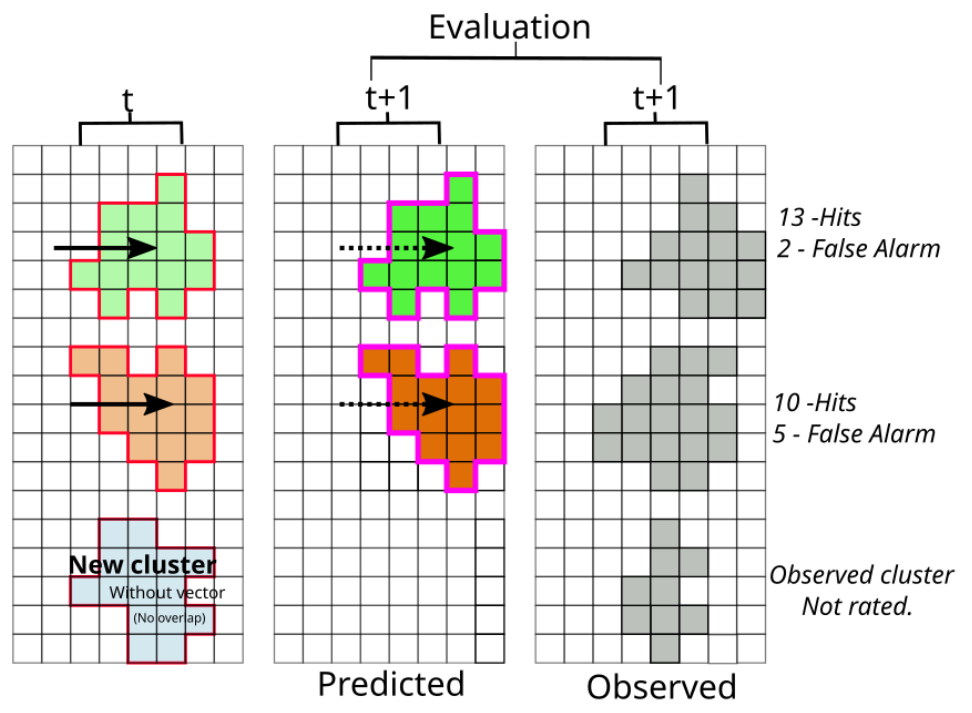
Figure 8. Example for validation of methods using extrapolation over rain cells and comparison between predicted and